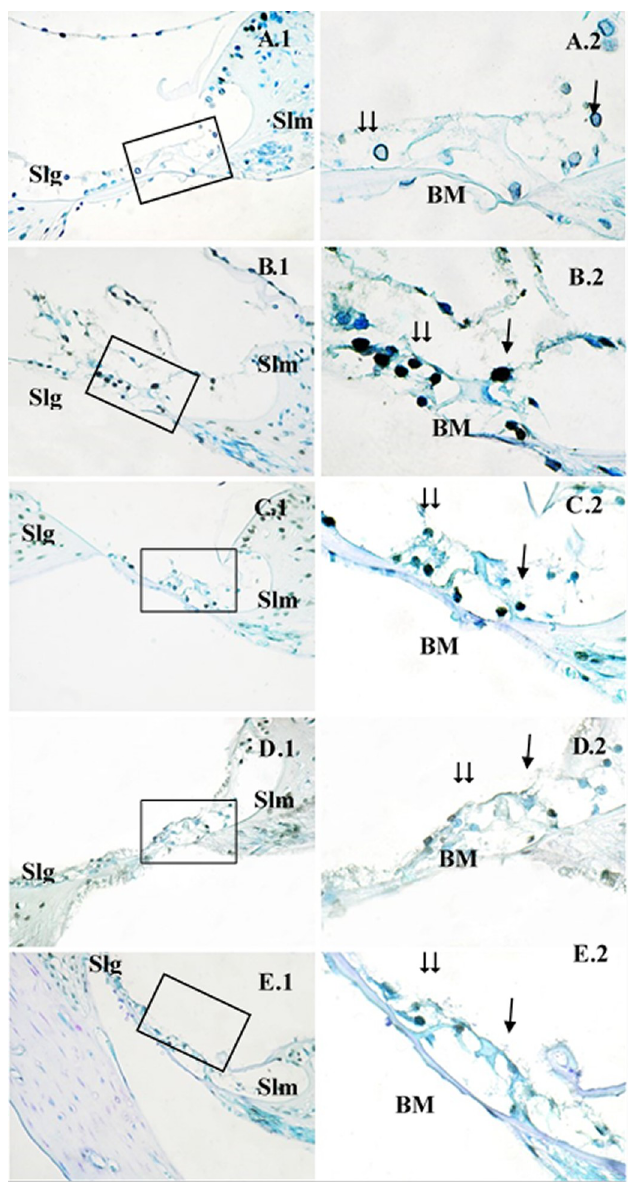
Fig 4. TUNEL staining in the cochlear Corti organ of the rat groups. ! : Inner hair cells, ⇉ : Outer hair cells, Slm: Spiral limbus, Slg: Spiral ligament, BM: Basilar membrane, Control (A), DM (B), DM+PTS10 (C), DM+PTS20 (D), DM+PTS40 (E). Corti organ X40 (1), Corti organ X100 (2). Methyl-green ground